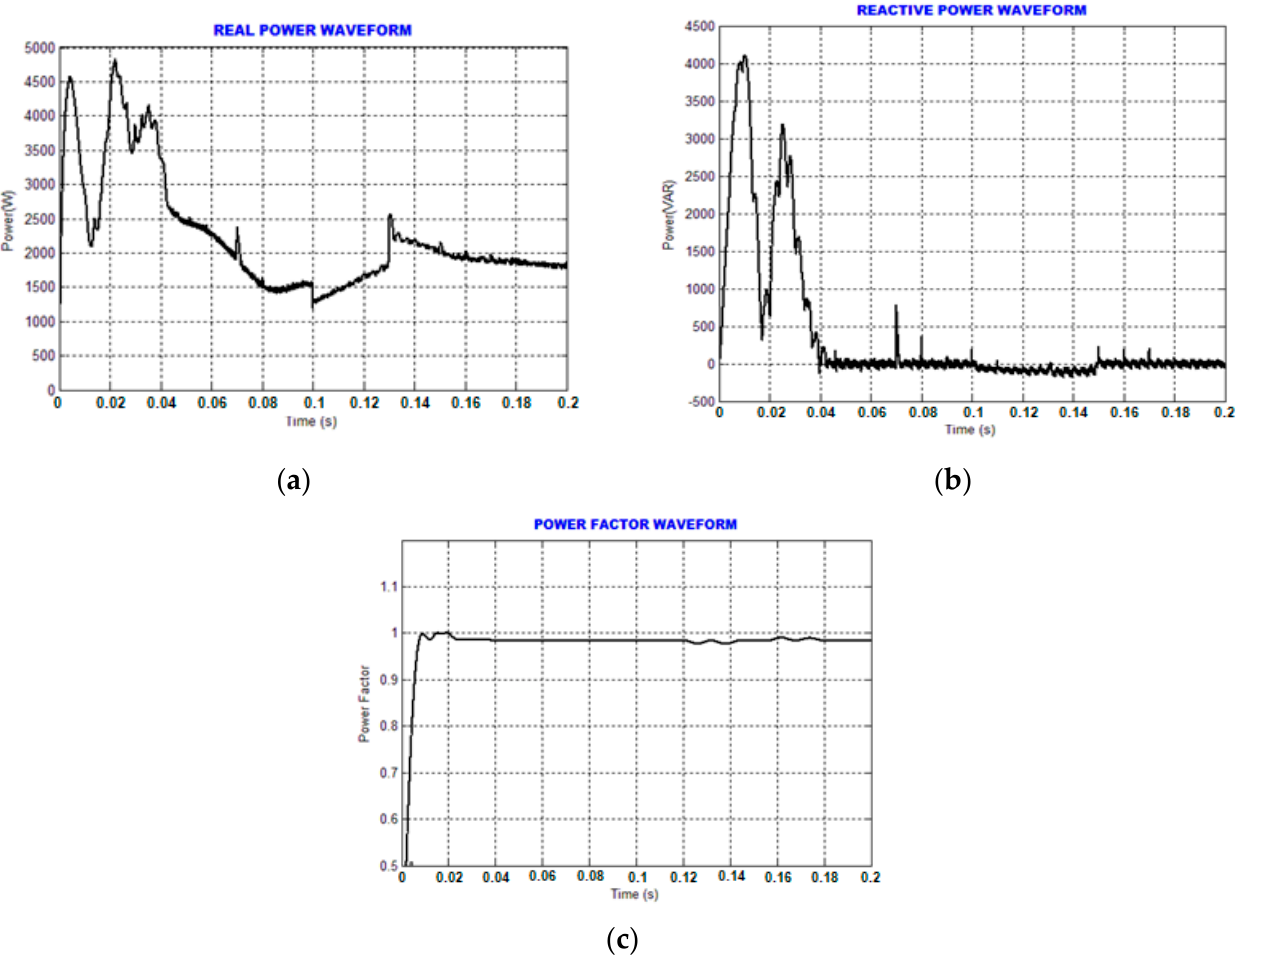
Figure 13. Illustration of ( a ) real power; ( b ) reactive power; ( c ) power factor.